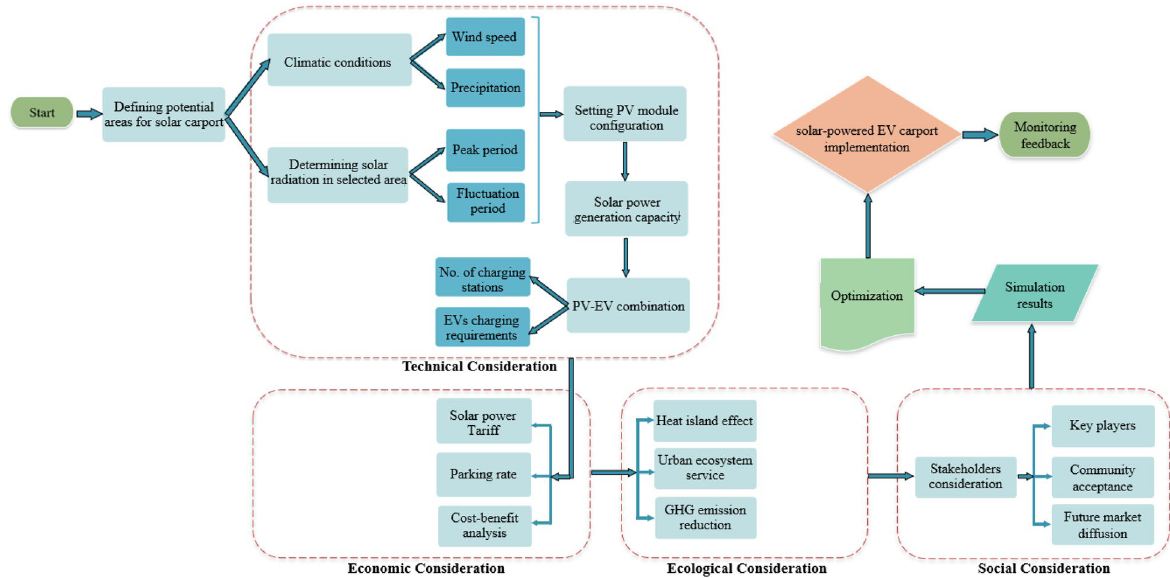
Figure 8. Flowchart illustrating the configuration of solar power carport with EV charging